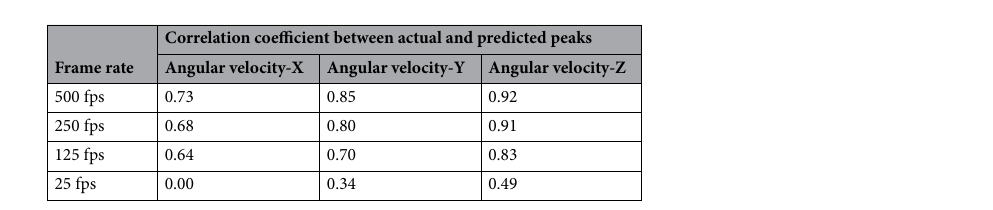
Table 2. Correlation coefficients for different frame